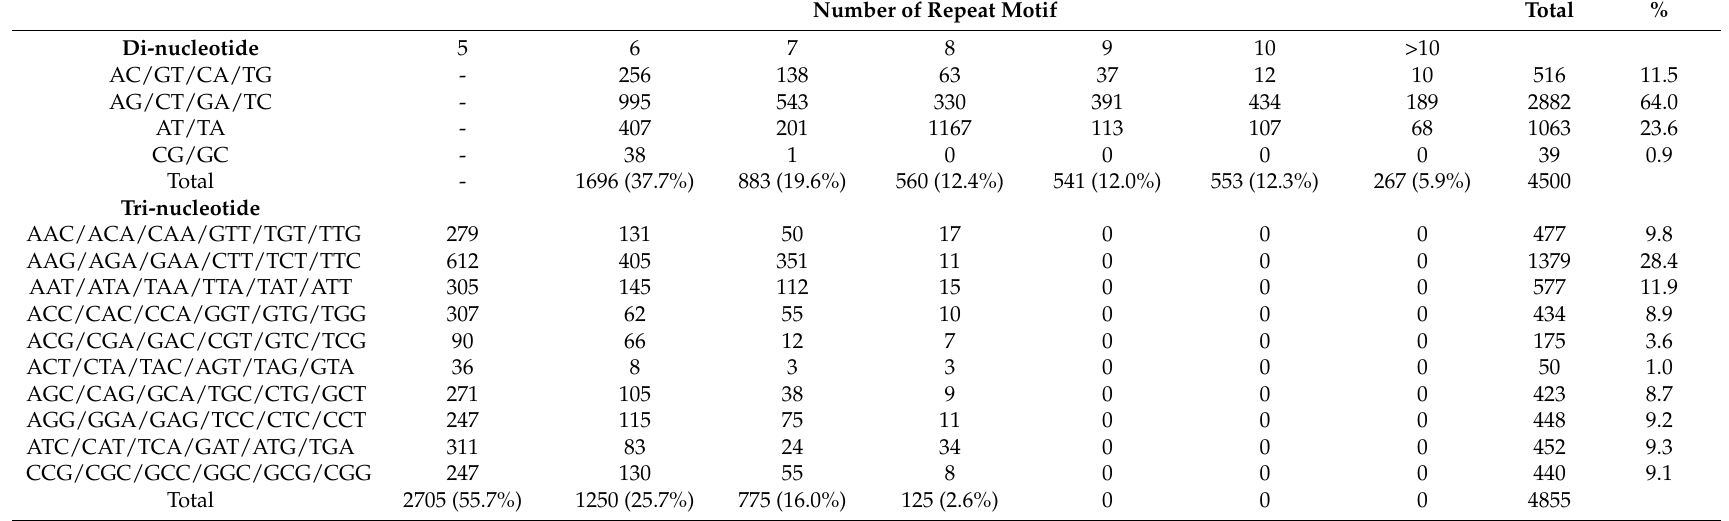
Table 4. Frequency distribution of di- and tri-nucleotide motif repeat in this de novo